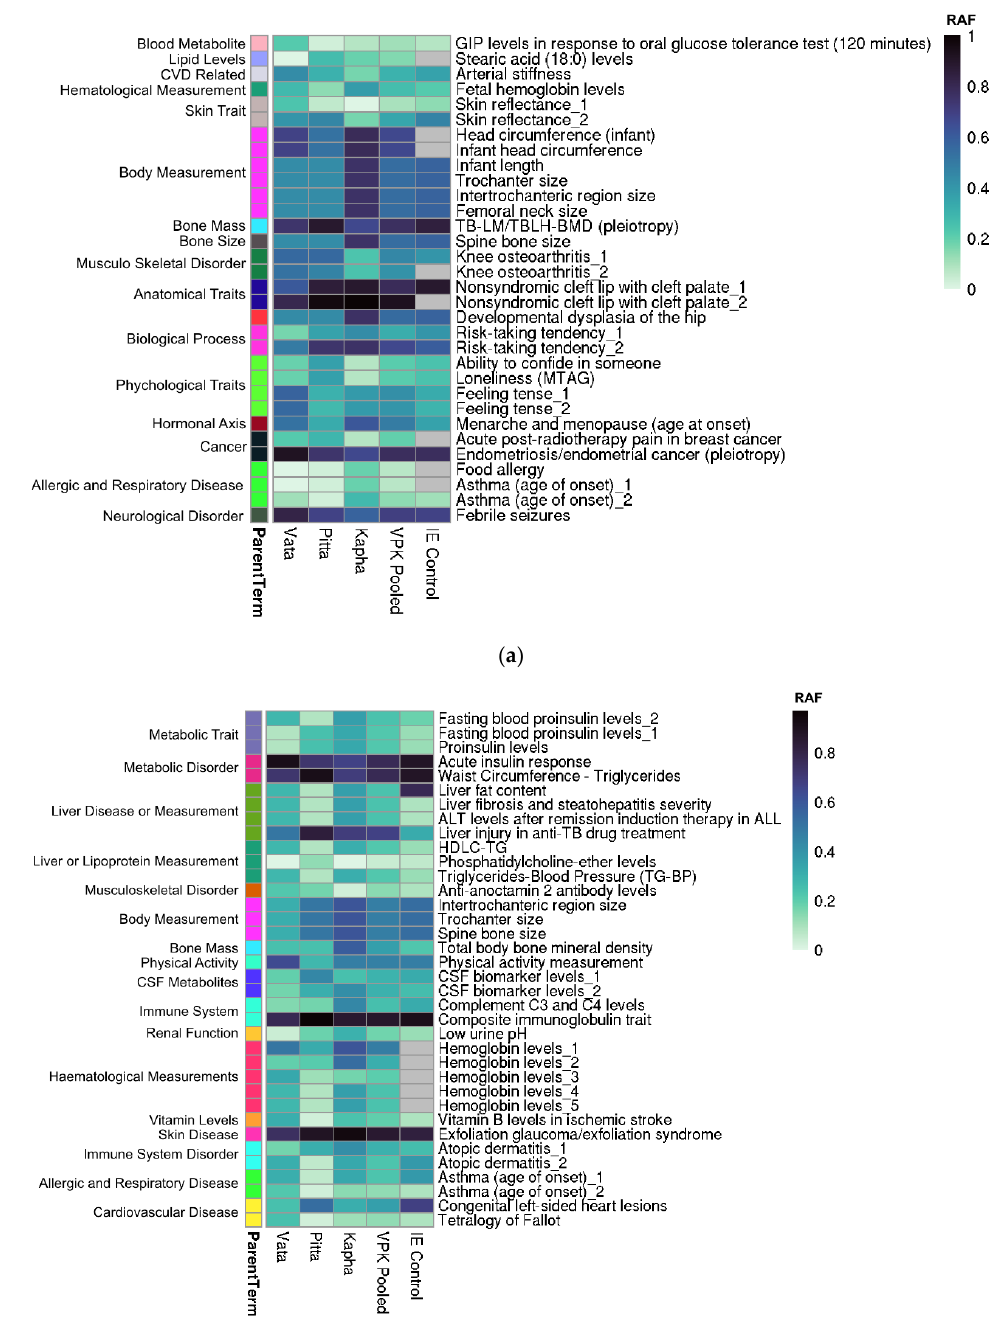
Figure 2. Heat Map showing pattern of risk allele frequencies (RAF) for enriched GWAS dis- eases/traits across Prakriti groups in ( a ) NI and ( b ) Vadu cohort. Enrichment was performed for V, P, K differentiating diseases/traits against GWAS catalog. In case a disease/trait has more than 1 SNP associated, it is indicated by underscore followed by number. RAF increases as we go from lighter towards darker color. Cells with grey color denote RAF is unavailable for that disease/trait. Disease/Traits on right side have been grouped into Parent Term (left side grouping), as mentioned in GWAS catalog.